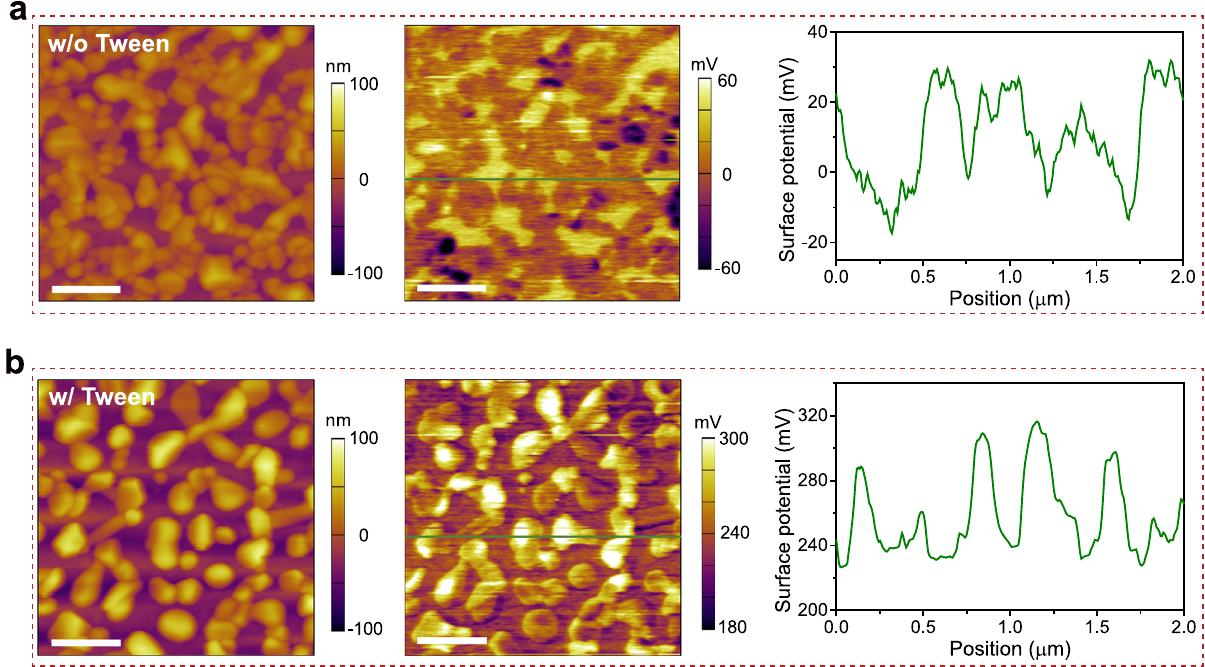
Fig. 3 Height (left), surface potential (middle) images, and corresponding line scans of cesium – copper – iodide fi lms. Scale bar, 500 nm. a Without Tween. b With Tween. The inclusion of Tween increases the average surface potential of cesium – copper – iodide fi lm. The surface potential of the control fi lm ranges from − 99 to 69 mV, and that of the fi lm with Tween is from 183 to 326 mV.